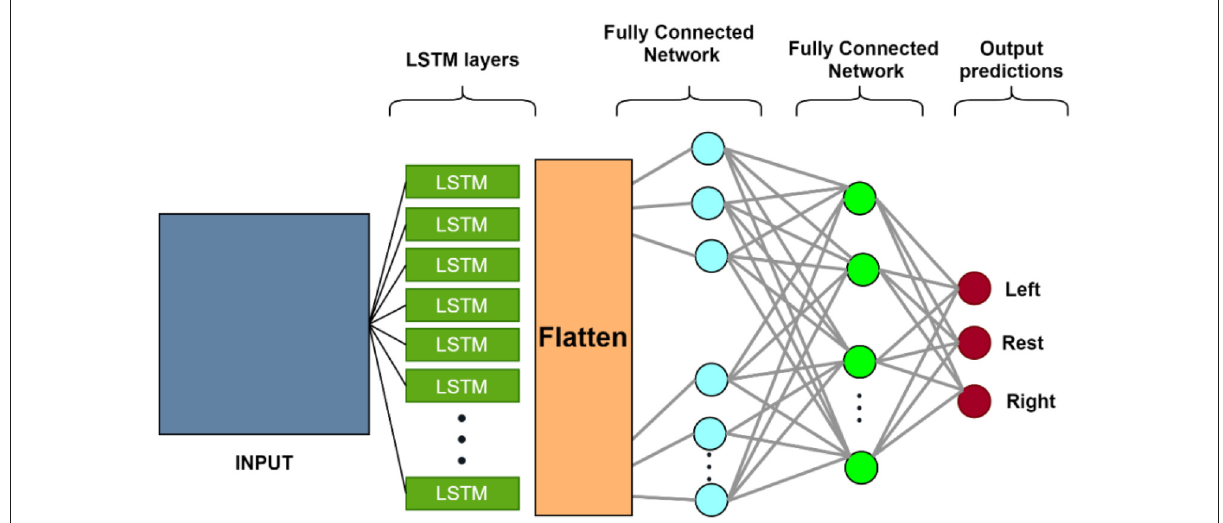
FIGURE7 The structure of the LSTM neural network. Each LSTM neuron accepts sequential input data and has three regulators (Input-, output- and forget- gate). It processes the input sequence and determines features based on input data. The remaining structure consists of a dense neural network of three layers (Balardin et al., 2017). LSTM, long short-term memory.